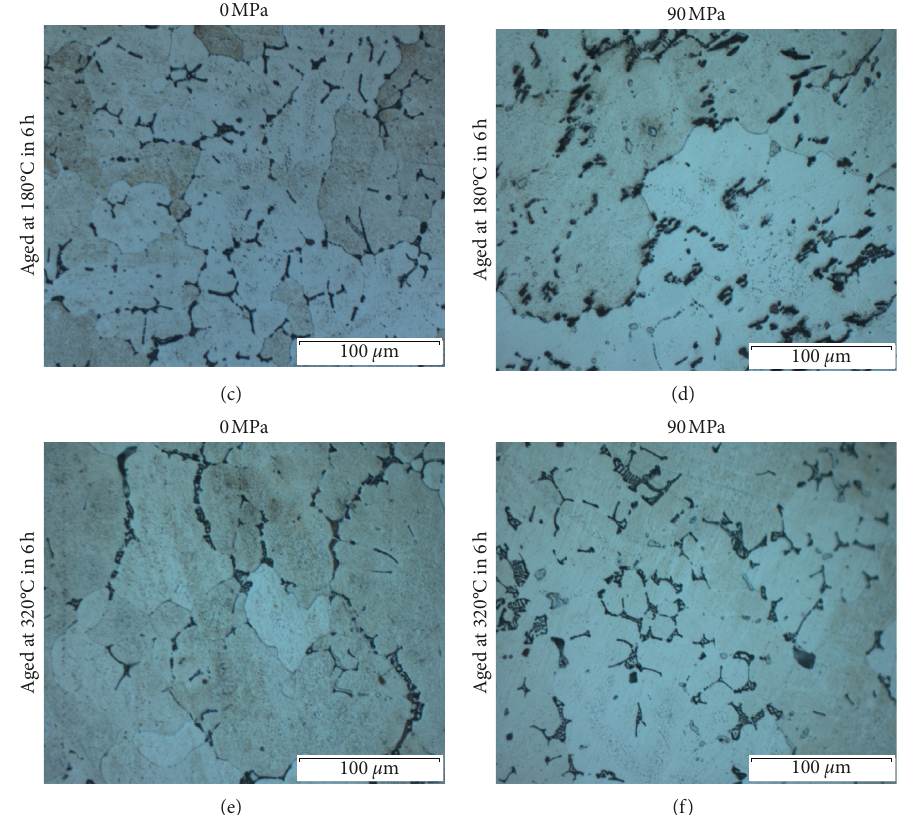
Figure 6: Optical micrographs of the 2017A alloy in heat treatment conditions.